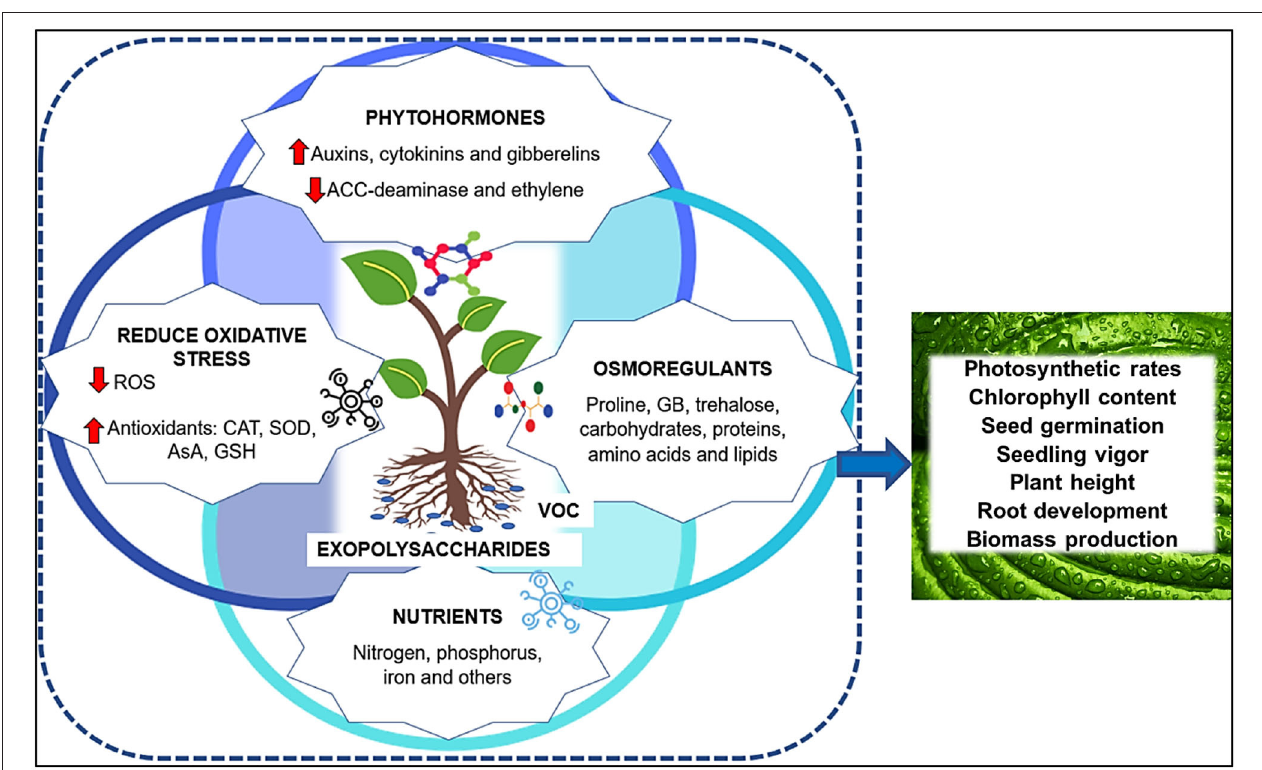
FIGURE 1 | Beneficial microbes improve plant growth by enhancing the availability of nutrients, the regulation of phytohormones, and increasing plant tolerance against stresses. PGPM act as biofertilizer, increasing macro and micronutrient availability. They increase the concentrations of auxin, gibberellin, cytokinin, ACC-deaminase, and reduce ethylene levels. Beneficial microbes also produce volatile metabolites (VOC), that may induce disease resistance and abiotic stress tolerance. In addition, PGPM mitigate stress by increasing exopolysaccharides, osmoregulants (such as glycinebetaine—GB), and antioxidants (including catalase—CAT, superoxide dismutase—SOD, ascorbate—AsA and glutathione—GSH), reducing the reactive oxygen species—ROS and oxidative stress. Thus, PGPM promote the increase of leaf area, chlorophyll content, photosynthetic rates, seed germination, seedling vigor, plant height, root development and biomass production of